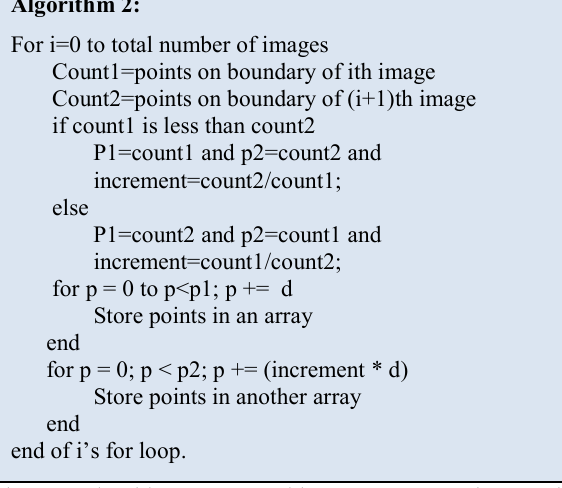
Fig.10 Algorithm to combine contour points using interpolation to build 3D mesh